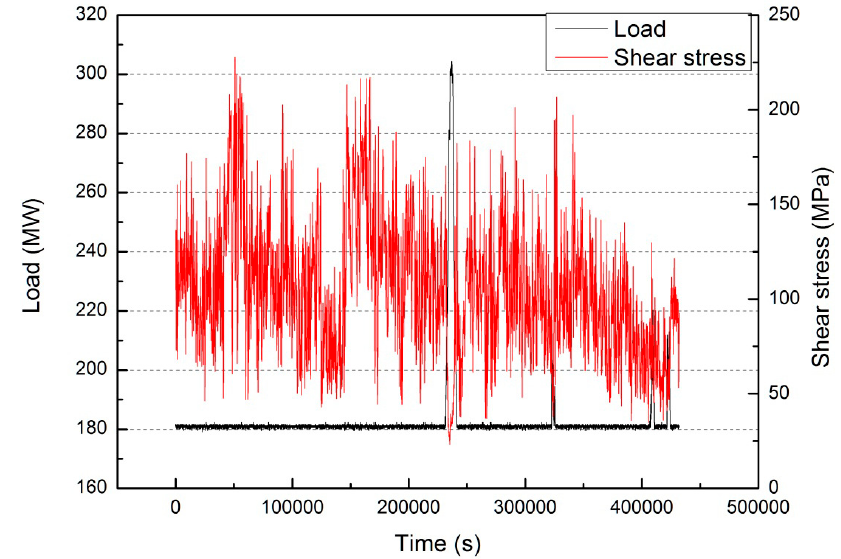
Figure 17. Shear stress cycle and load vs. time at the highest tube temperature difference point.